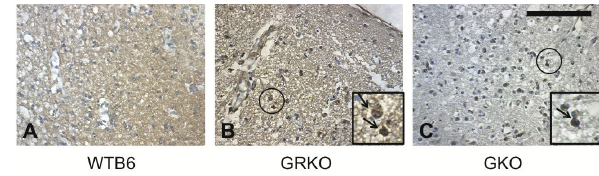
Figure 3. Immunohistochemical staining for nonstructural protein 3 in the piriform cortex. Brains from WTB6 (A), GRKO (B), and GKO (C) mice were examined 7 days after intranasal infection with 10 5 pfu NSV. Representative sections from at least 3 mice were stained with a rabbit polyclonal antibody to nsP3 followed by biotinylated antibody to rabbit IgG, avidin-peroxidase and DAB. nsP3-positive cells were more frequent in GRKO and GKO mice. Insets contain magnified versions of encircled cells. X400. Scale bar = 100 um.